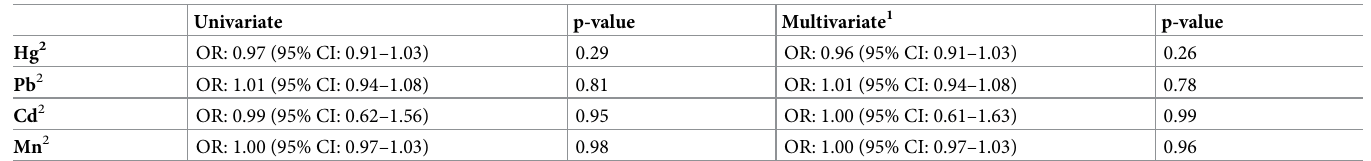
Table 2. Association between heavy metal concentrations and cleft